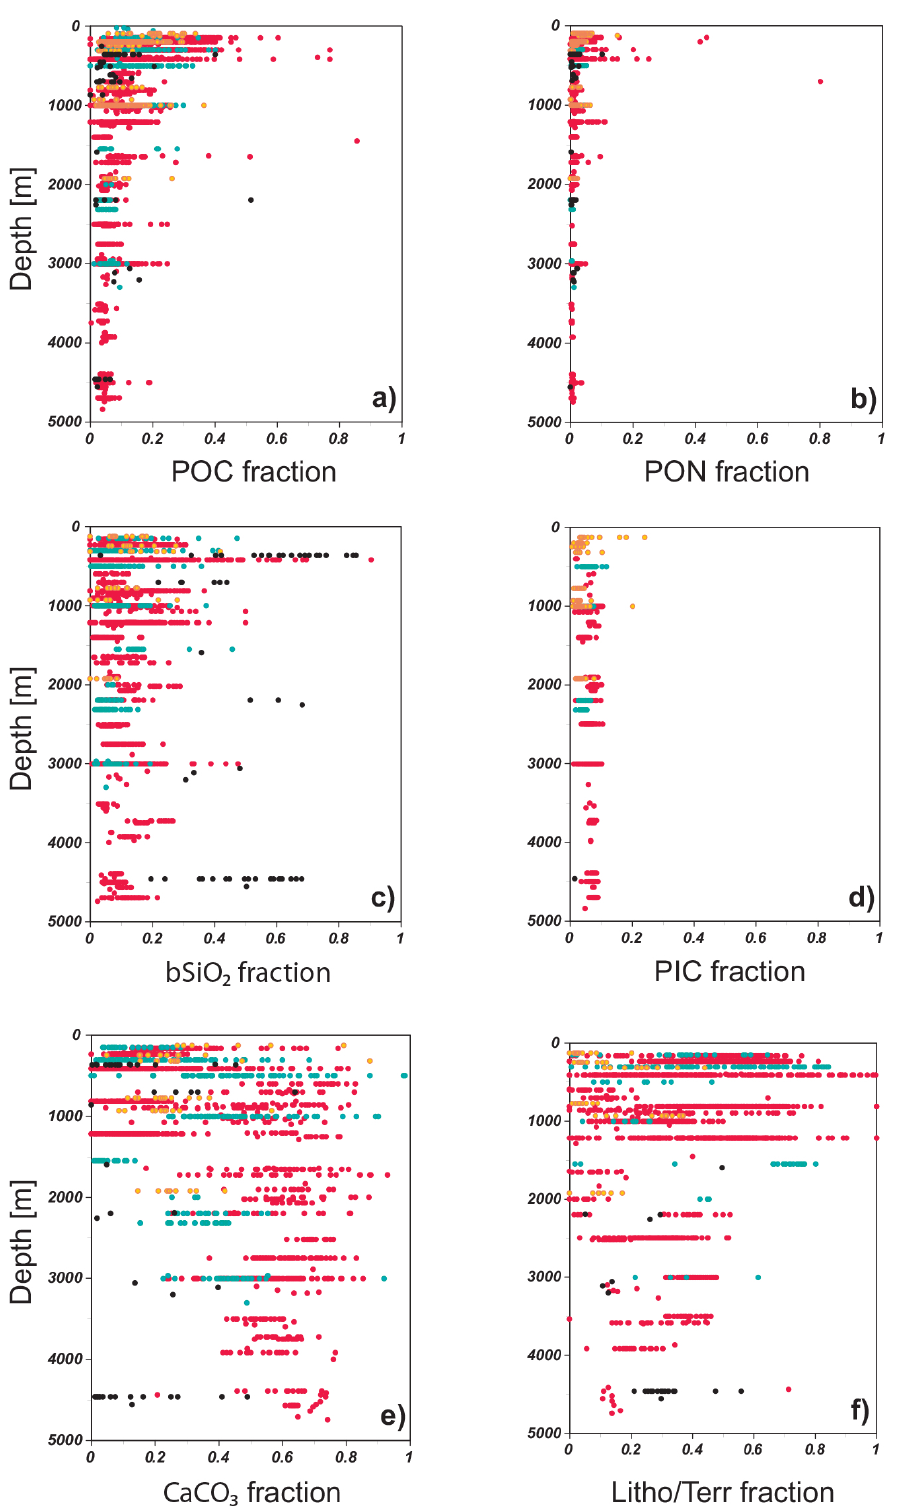
Figure 6. Fraction of POC, PON, and bSiO 2 , PIC, CaCO 3 and Litho / Terr downward fluxes relative to Tot_Mass flux. Data points are colour- coded per ocean domain: Atlantic (red dots), Mediterranean (orange dots), Arctic (blue dots), and Southern Ocean (black dots). Few outliers (fraction > 1) were excluded from the